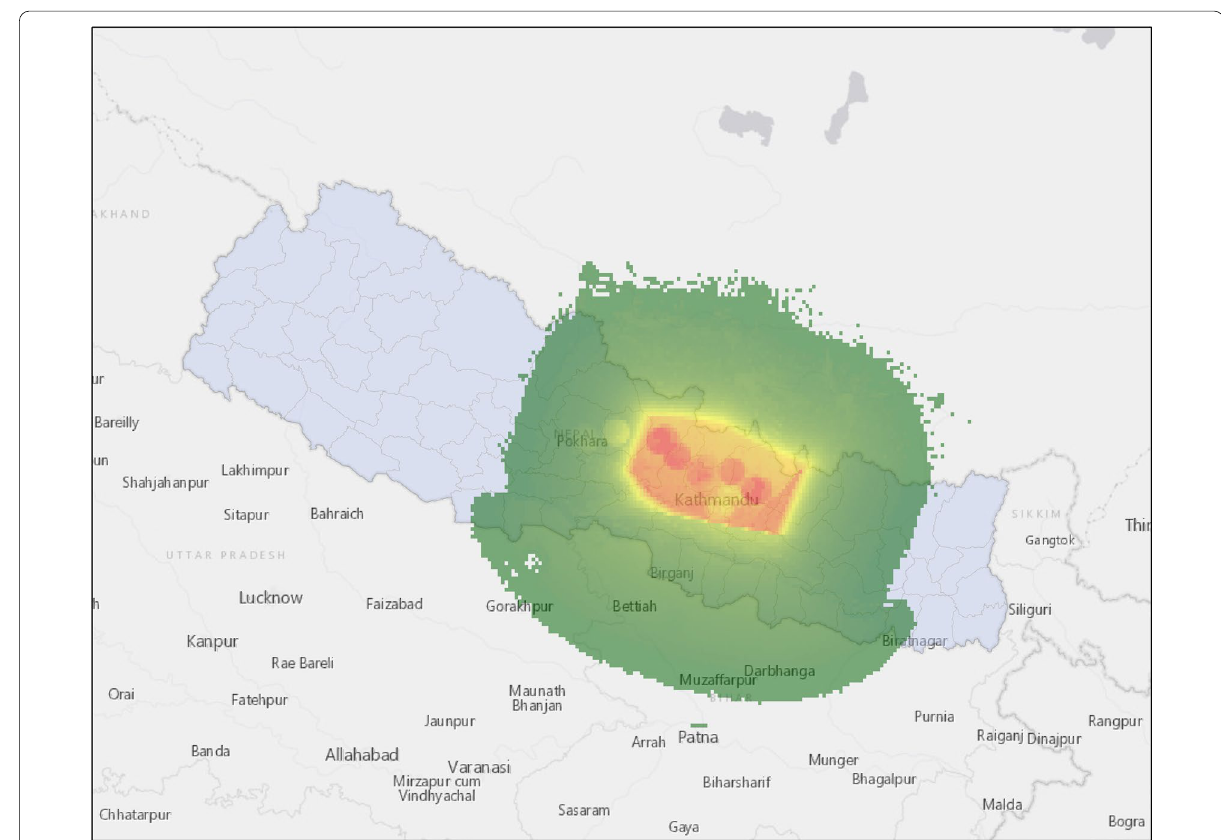
Fig. 1 Nepal and the Gorkha earthquake. The underlying blue colour shows Nepal, whereas the green to red outlines the extent and intensity of the earthquake, with red being the most impacted areas. Source : USGS Shakemap and ArcGIS